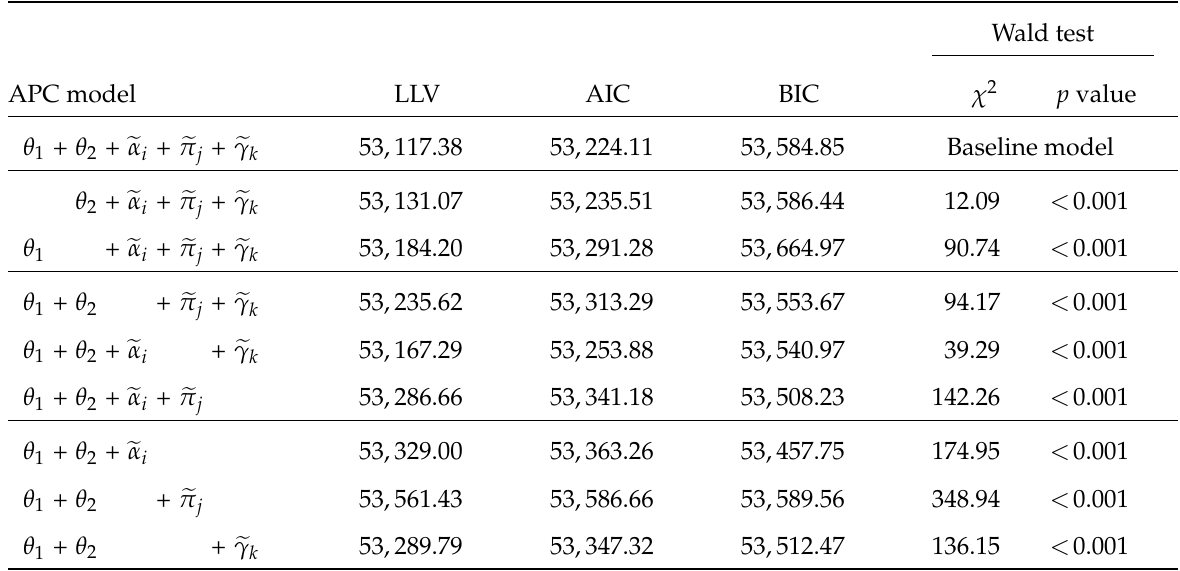
Table 4: Fit statistics of diachronic L-APC model versus selected